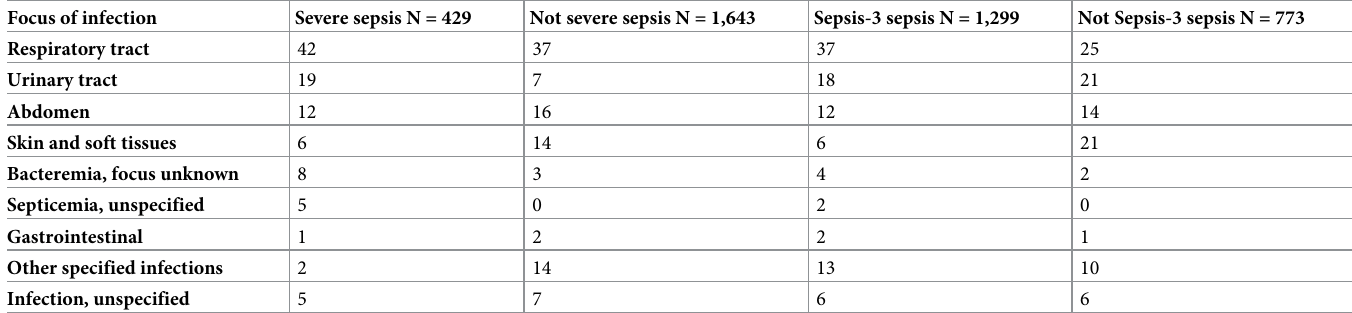
Table 6. The focus of infection in 2,072 consecutive patients with community onset bacterial infection. Values shown are percentages. Focus of infection